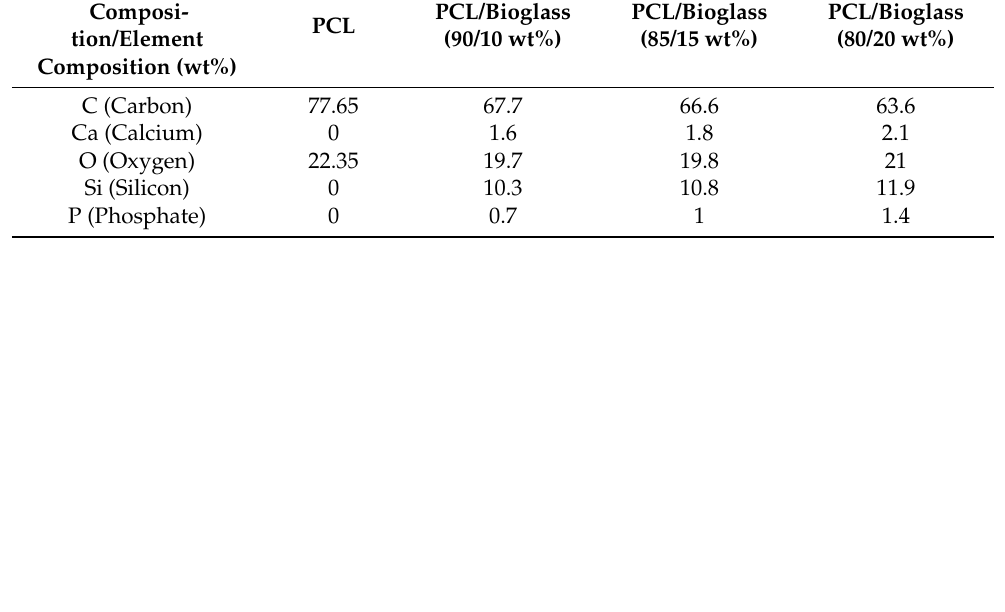
Table 5. The element composition of the printed scaffolds.